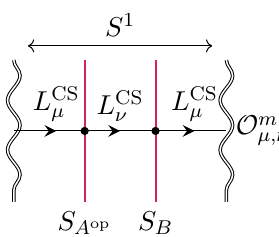
Figure 9. The TQFT T is obtained by compactifying the 3d SU( N ) N CS on S 1 with the A C B insertion of surface operators S A op and S B transverse to S 1 . The left and right wiggly lines are identi(cid:12)ed in the picture. The topological loop operators L CS and L CS wrapped around S 1 corre- (cid:22) (cid:23) spond to local operators of the 2d TQFT denoted by O m where m = 1 ; : : : ; Z ( A ) (cid:23)(cid:22) Z ( B ) (cid:23)(cid:22) (cid:22);(cid:23)